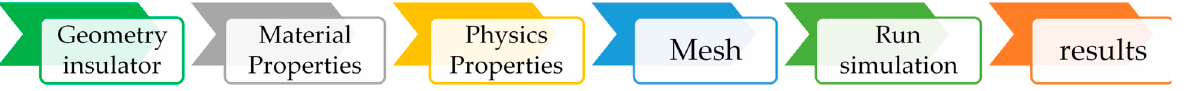
Figure 12. Modeled polymeric insulator structure. Table 4. Material properties of insulator model. Materials